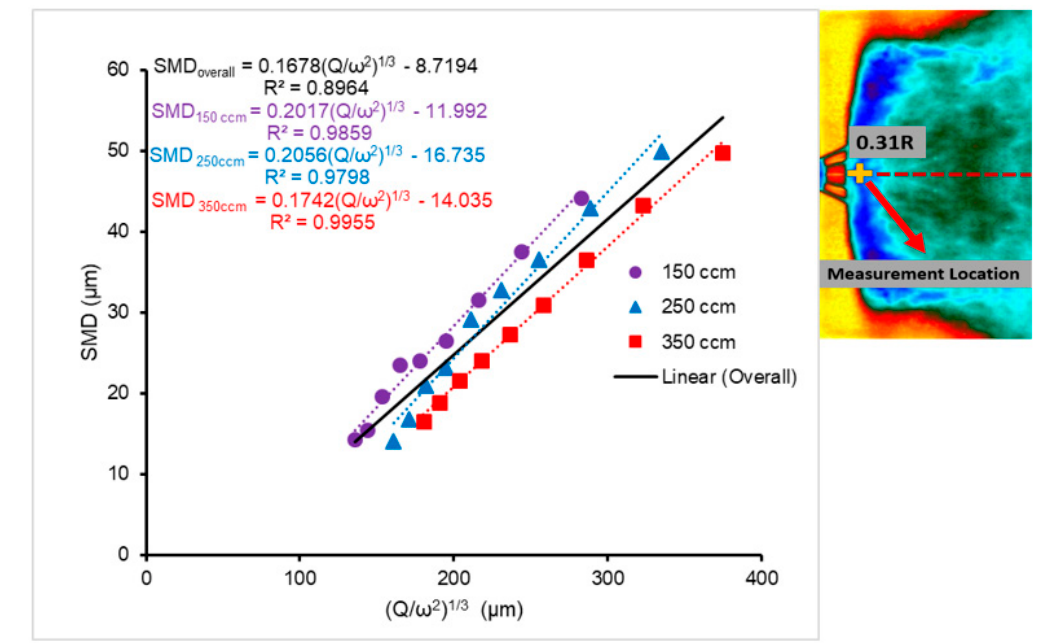
Figure 14. The relationship between the process parameters and the SMD at 0.31R horizontal location and 0R vertical distance from the cup center.